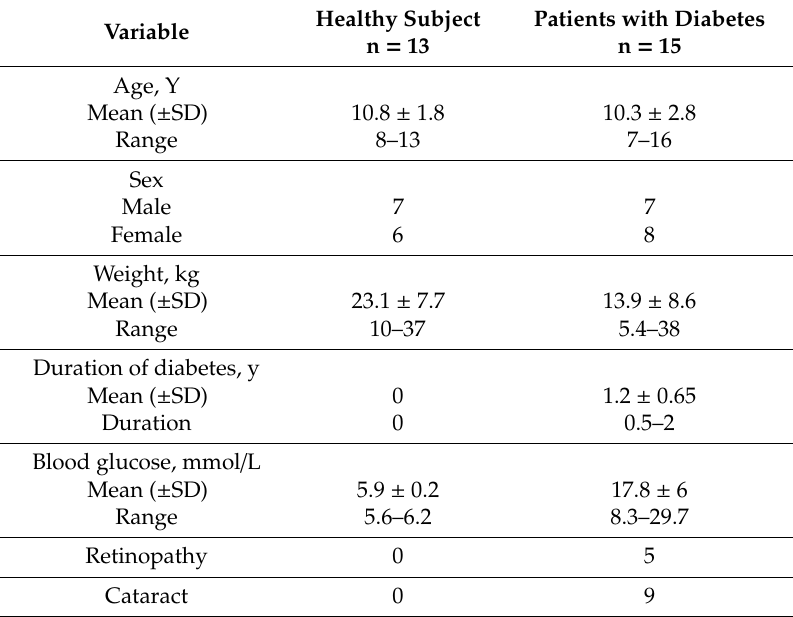
Table 1. Clinical characteristic of the study